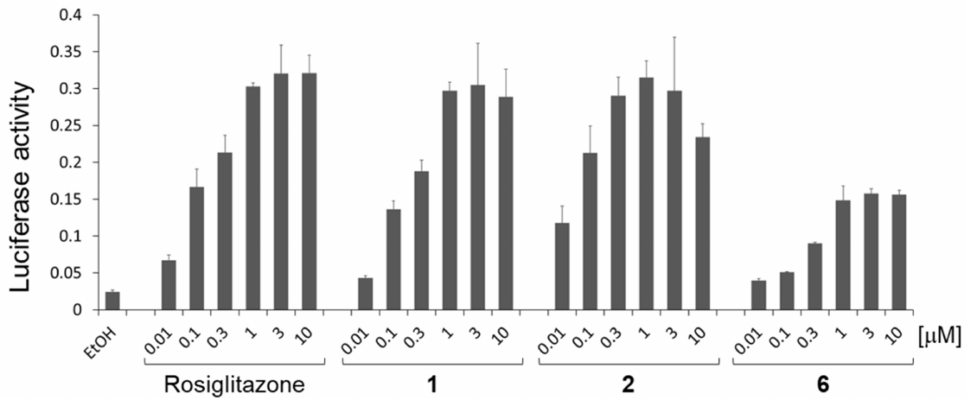
Figure 3. Transcriptional activity of synthetic compounds 1 , 2 , and 6 evaluated in Cos-7 cells using a dual luciferase assay with a GAL4-PPAR γ chimera expression plasmid (pSG5- GALhPPAR γ ), a reporter plasmid (MH100 × 4-TK-Luc), and an internal control plasmid containing sea pansy luciferase expression constructs (pRL-CMV). The data represent the mean ± SD of three independent experiments. Table 2. The EC 50 values of compounds 1 , 2 , and 6 .